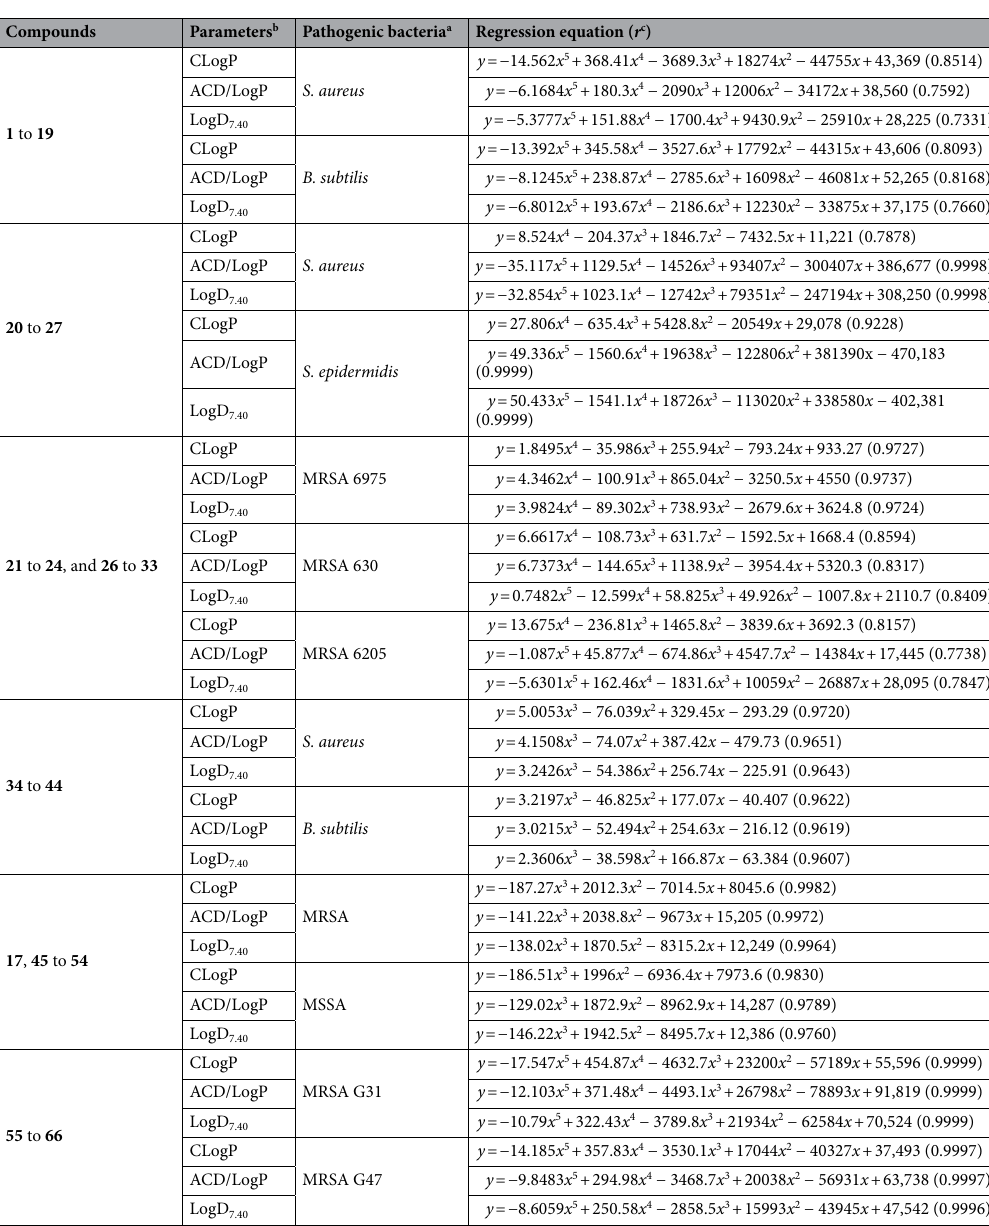
Table 7. Regression equations between the physicochemical parameter ( x ) and the antimicrobial activity ( y ) to a certain pathogenic microorganism. a The antimicrobial activity ( y ) was expressed as MIC or MIC 90 to a certain pathogenic microorganism. S. aureus , Staphylococcus aureus ; S. epidermidis , Staphylococcus epidermidis ; B. subtilis , Bacillus subtilis ; MRSA, methicillin-resistant Staphylococcus aureus ; MSSA